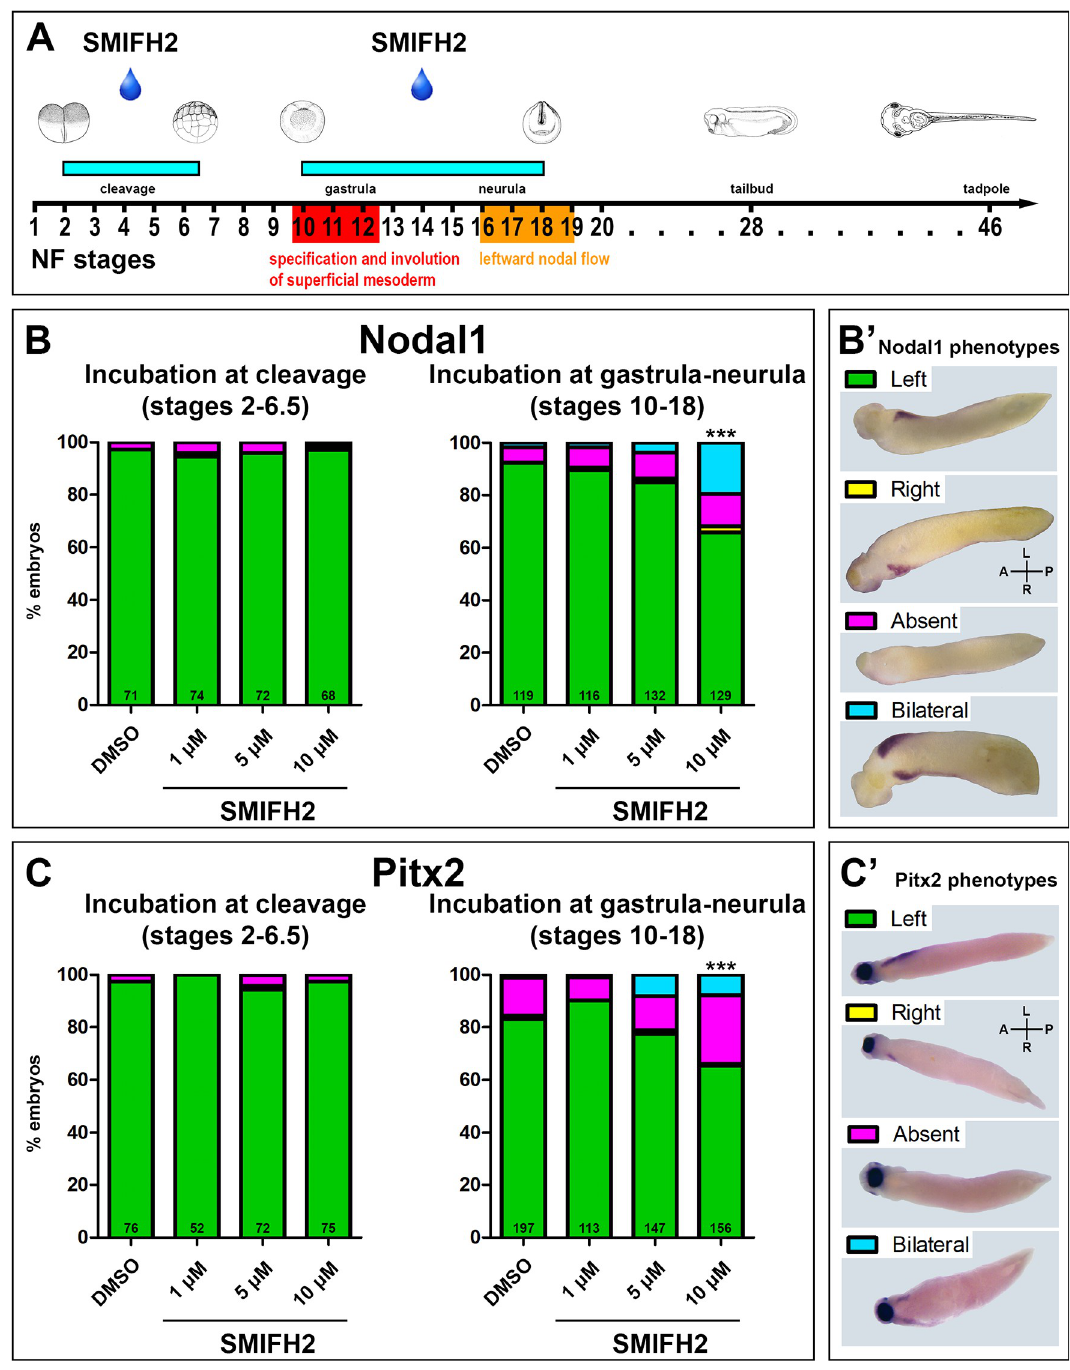
Fig 1. Molecular left-right patterning after formin inhibition. (A) Scheme of time course of chemical treatment and stages of LR analysis. (B, B’) Formin inhibitor SMIFH2 had no effect on nodal1 expression patterns in the embryos treated during cleavage (N = 3) and reduced the proportion of left-sided nodal1 expression in the embryos treated during gastrulation and neurulation (N = 6, p = 0,00000313 for 10 μ M SMIFH2). (B) Summary of experimental data. (B’) Representative images of formin-modulated stage 28 tailbud embryos displaying left-sided and abnormal (right, absent and bilateral) expression of nodal1 , ventral view. (C, C’) Formin inhibitor SMIFH2 had no effect on pitx2 expression patterns in the embryos treated during cleavage (N = 4) and reduced the proportion of left-sided pitx2 expression in the embryos treated during gastrulation and neurulation (N = 7, p = 0,0005445 for 10 μ M SMIFH2). (C) Summary of experimental data. (C’) Representative images of formin-modulated stage 28 tailbud embryos displaying left-sided and abnormal (right, absent and bilateral) expression of pitx2 , ventral view. A, anterior; L, left; P, posterior; R, right. ��� , p- value < 0.001 compared with the DMSO control, two-proportions z-test with Bonferroni correction; N, number of experiments. Numbers at the base of columns represent number of analyzed